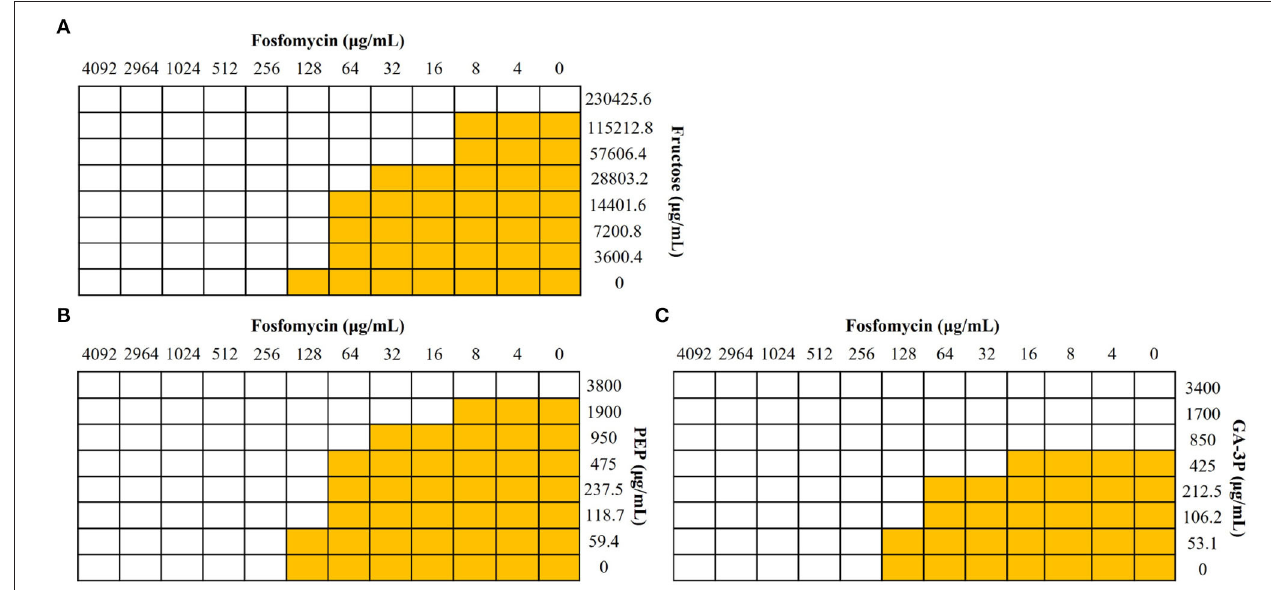
FIGURE 1 | Effect of different metabolites in the activity of fosfomycin against S. maltophilia . Checkerboard analyses were performed with the S. maltophilia D457 strain. Wells with bacterial growth are represented in yellow, and wells in which there was no growth are represented in white. (A) Fructose showed a synergistic effect (FICI value of 0.31). (B) PEP and (C) glyceraldehyde-3-phosphate (GA-3P), despite not having a synergistic effect, FICI values of 0.56 and 0.62, respectively, showed an additive effect and improved fosfomycin activity against S. maltophilia